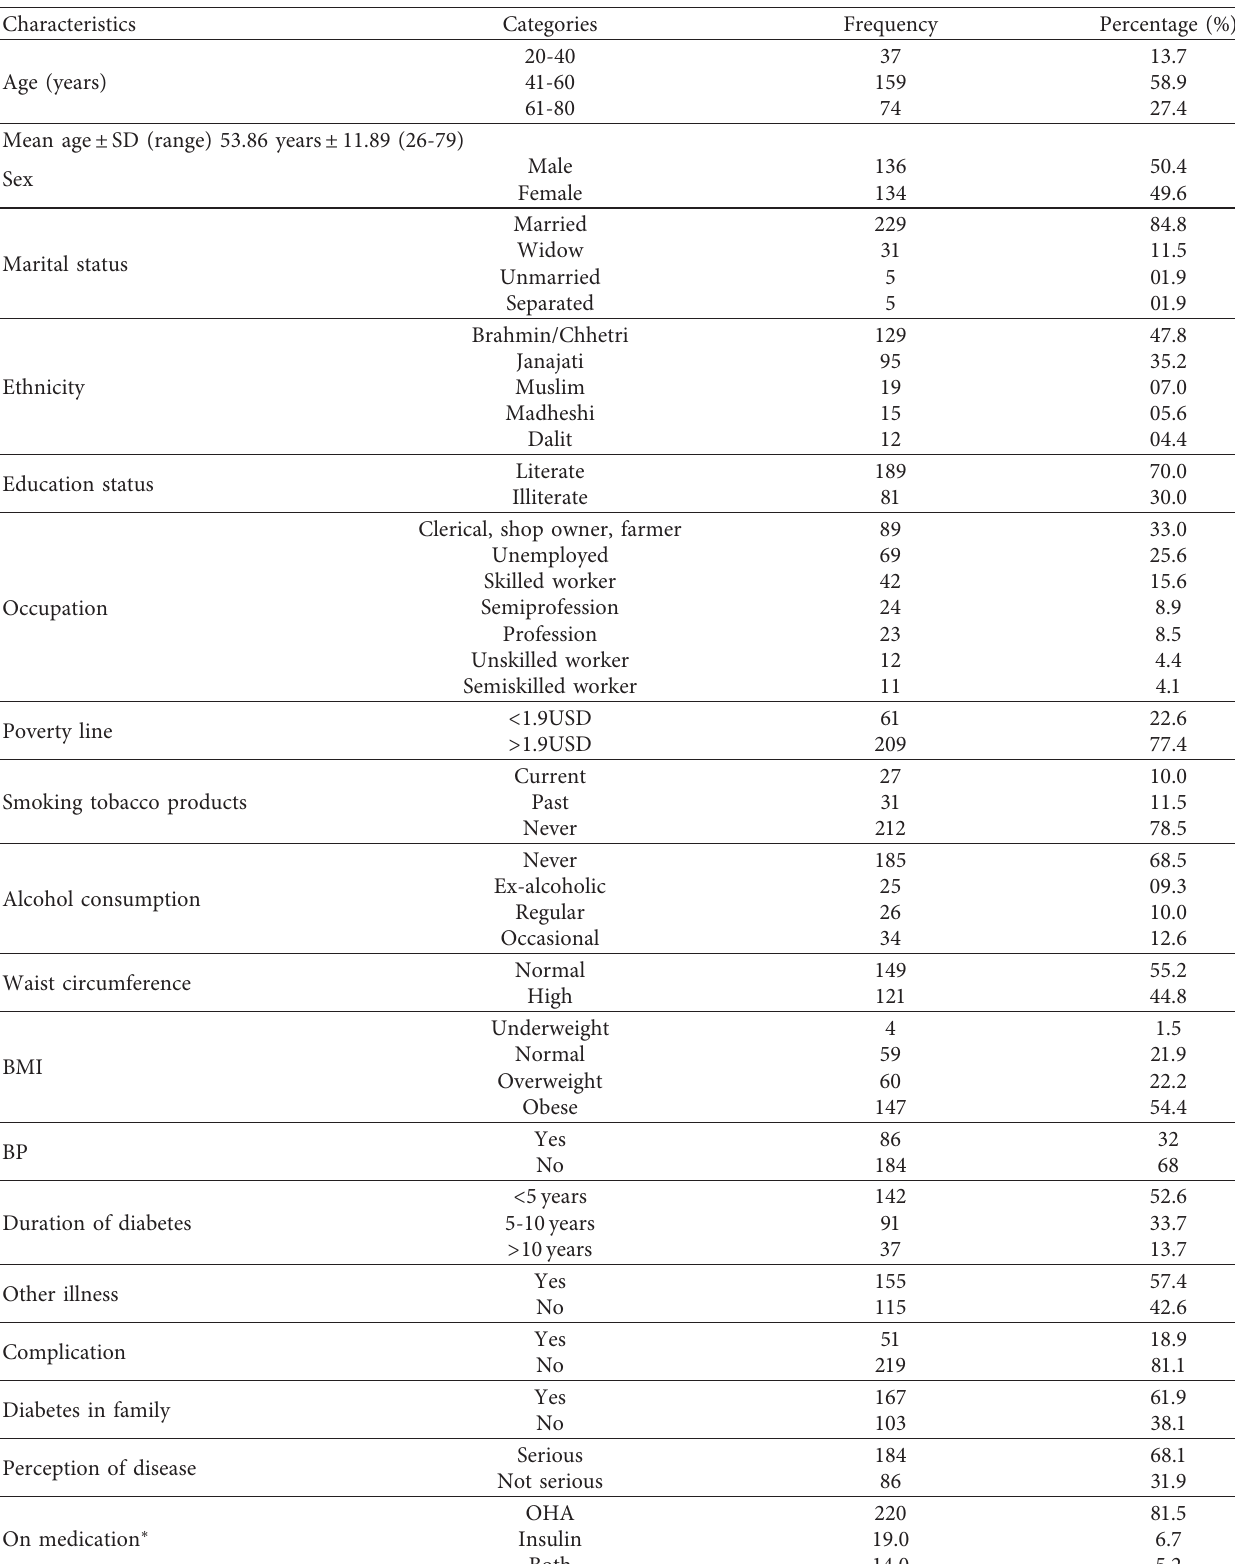
Table 1: Demographic characteristics of the participants ( n �